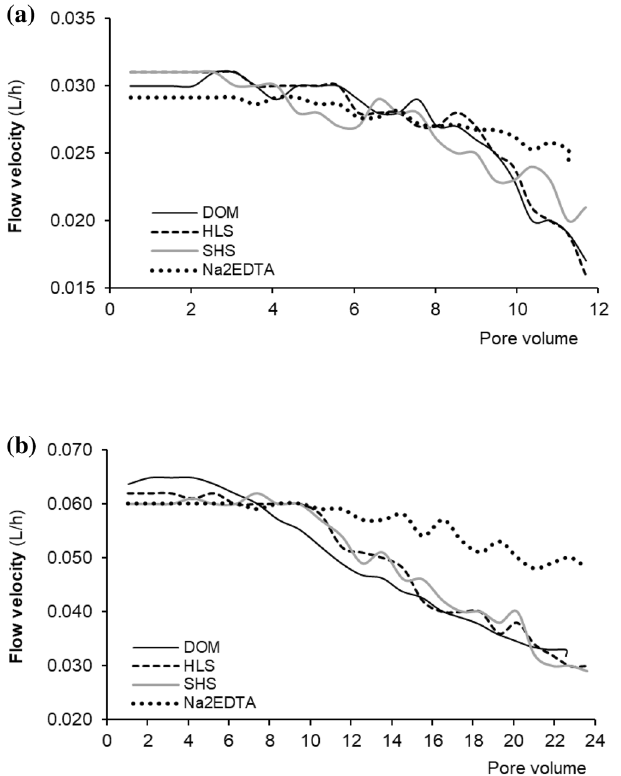
Figure 3. Flow velocity and pore volume during soil flushing with DOM, HLS, SHS and Na 2